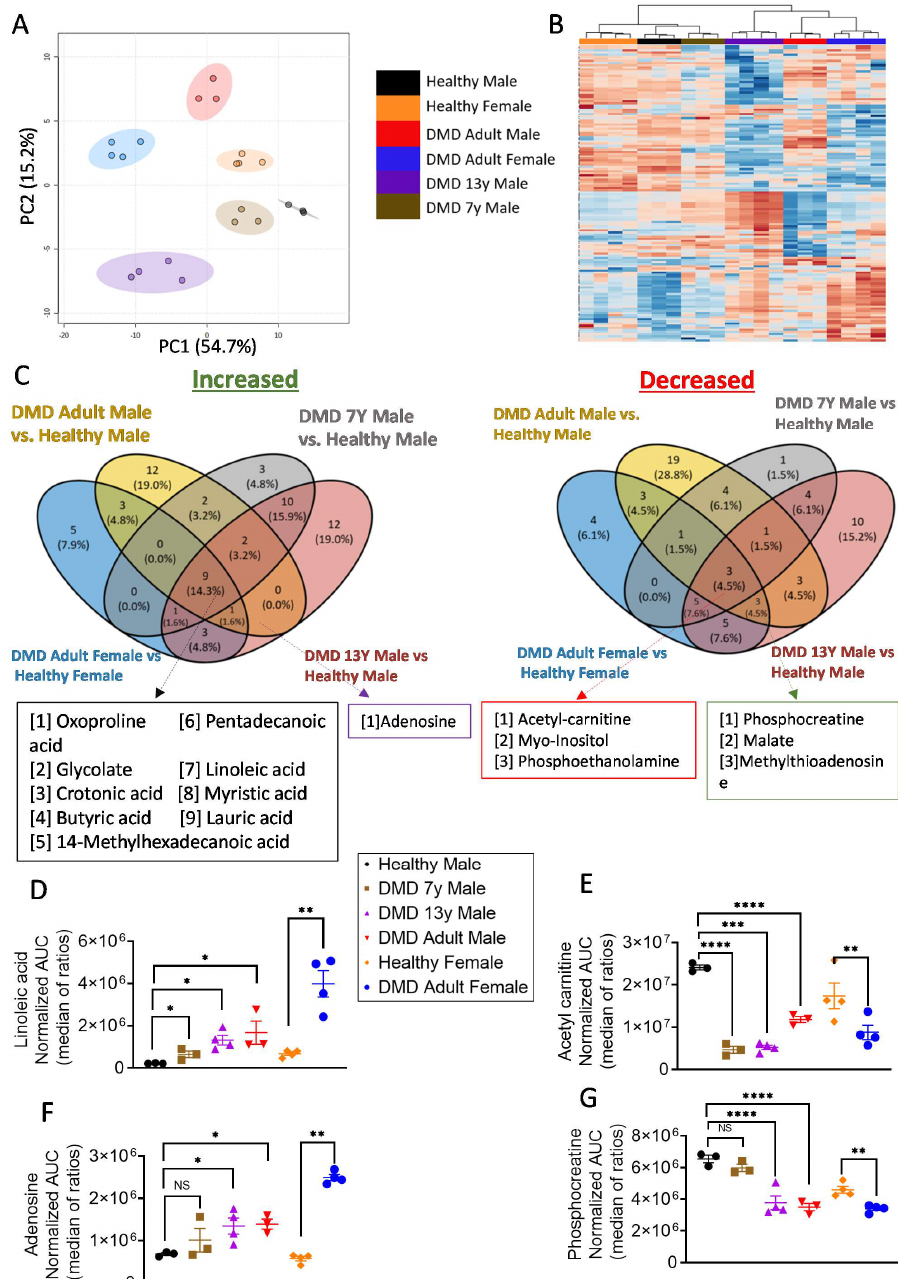
Figure 1. Metabolomics analysis of iPSC-CMs. ( A ) PCA of 1700 chromatographic feature intensities for iPSC-CMs, colored by group: DMD adult male (black, n = 3), DMD adult female (blue, n = 4), DMD 13-year-old (13y) male (purple, n = 4), DMD 7-year-old (7y) male vs. healthy male (brown, n = 3) and healthy female (orange, n = 3). The PCA plot was created using Metaboanalyst. Analysis was applied on the log-transformed intensities, normalized by the median with auto-scaling. The colored ellipses represent 95CI areas. Group separation as captured by the first principal component distinguished more severe DMD phenotypes from the less severe and healthy ones. ( B ) Unsupervised clustering analysis presented by heatmap. Three of the four DMD CMs were clustered together apart from the healthy control, while the arrhythmia-free 7y CMs were clustered with the healthy control. The heatmap was created in Metaboanalyst, using the same chromatographic feature intensities as in panel ( A ) (Ward clustering, Euclidean distance). ( C ) Venn diagrams showing that the intersections of metabolites either increased ( left ) or decreased ( right ) in the comparisons indicated in the